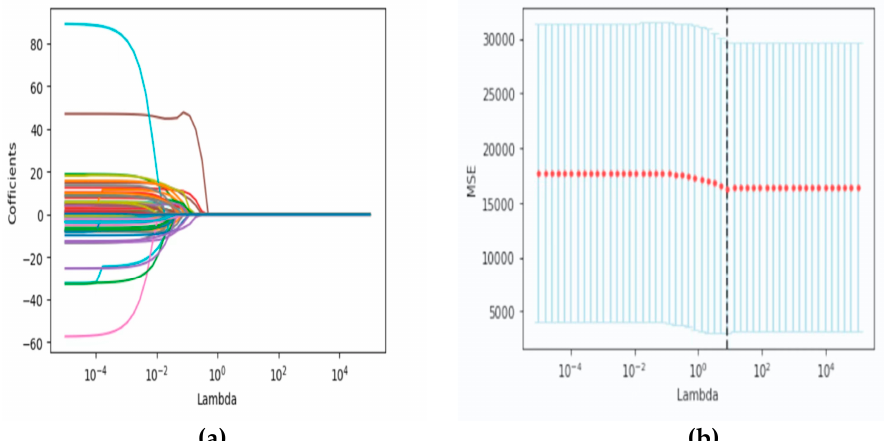
Figure 2. Variable selection based on LASSO regression. ( a ) LASSO coefficient path map; ( b ) Cross validation curve.